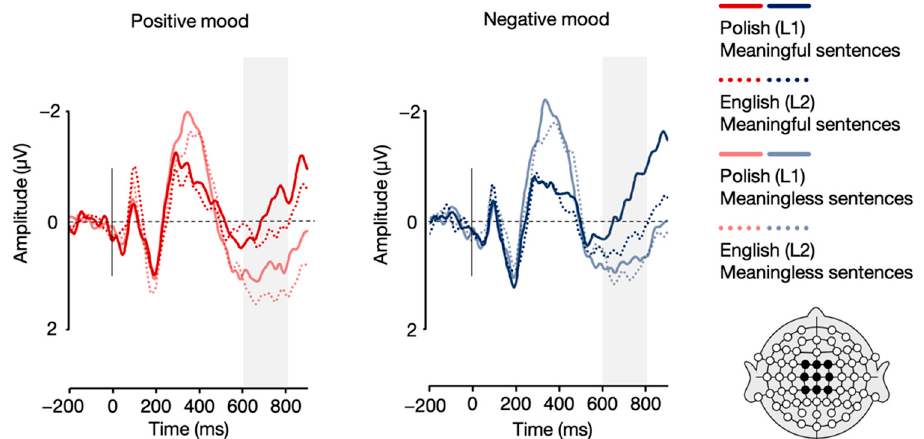
Figure 11. Grand averages for Polish (L1) and English (L2) meaningful and meaningless sentences in the positive and negative mood conditions over fronto-central (FC1, FCz, FC2), central (C1, Cz, C2), and centro-parietal (CP1, CPz, CP2) electrodes.